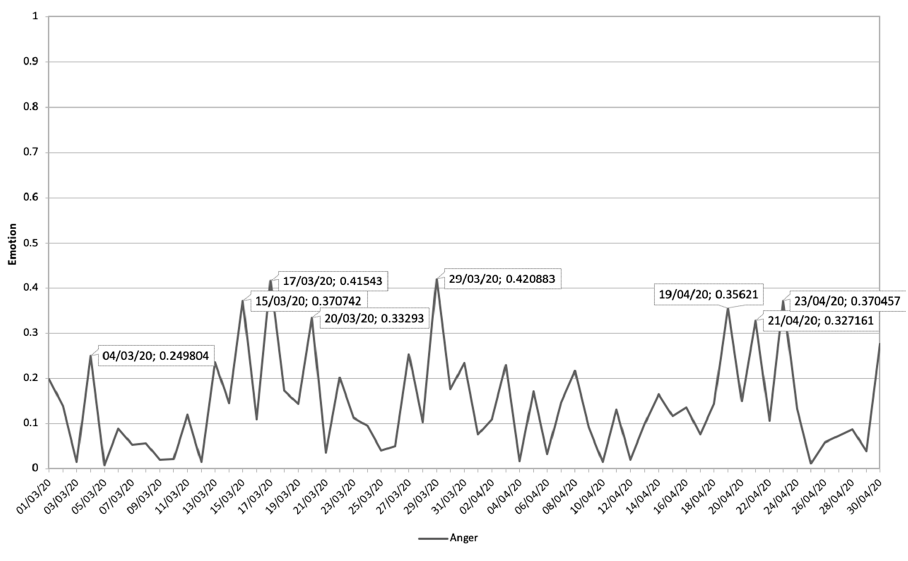
Figure 10. Anger emotion during the period 1 March 2020 until 30 / 04 / 2020 related to terms about COVID-19.